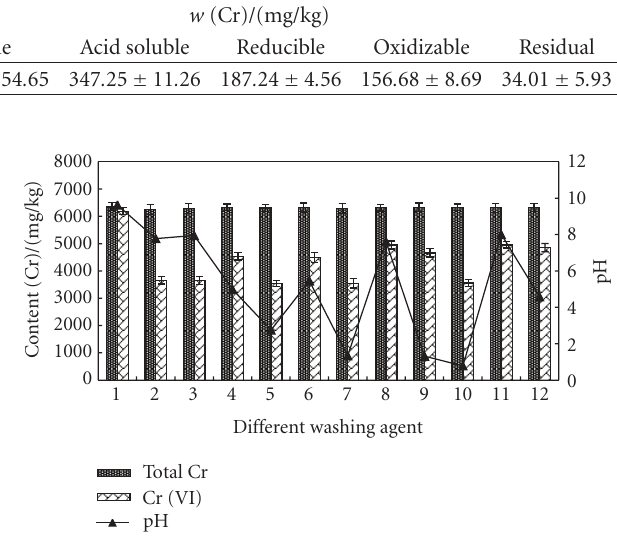
Figure 5: Total Cr and Cr (VI) content variation before and after washing. Washing agent: 1—water; 2—0.05 mol/L EDTA-Na 2 ; 3—0.1 mol/L EDTA-Na 2 ; 4—0.1 mol/L citric acid; 5—0.5 mol/L citric acid; 6—0.1 mol/L oxalic acid; 7—0.5 mol/L oxalic acid; 8— 0.1mol/L HCl; 9—0.5 mol/L HCl; 10—1mol/L HCl; 11—0.1 mol/L acetic acid; 12—0.5 mol/L acetic